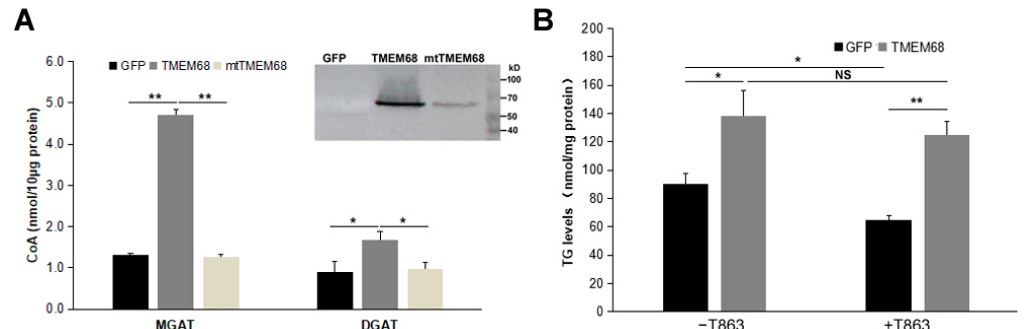
Figure 9. TMEM68 exhibites MGAT and DGAT activities. ( A ) Total membrane protein was extracted from 293/GFP, 293/TMEM68 and 293/mtTMEM68 cells. MGAT and DGAT activities of TMEM68 were measured by monitoring the released CoA from oleoyl-CoA in a TMEM68-mediated reaction containing 2-oleoyl-glycerol or 1-2-dioleoyl- sn -glycerol as the acceptor of oleoyl group. Immunoblot analysis of total membrane fraction isolated from HEK293 cells stably expressing GFP and TMEM68-GFP, transient expressing mtTMEM68. Migration of molecular mass standard proteins was indicated right of the figure. Data were presented as means ± SD. Asterisk indicated p values: * p < 0.05, ** p < 0.01, n = 3. ( B ) TG levels assays in HEK293 cells overexpressing GFP or TMEM68 in the absence or presence of T863. Cells were pretreated with T863 for 1 h or not, and then incubated with OA for 6 h. TG levels were quantified by an enzymatic triglyceride assay kit. Data were presented as means ± SD. NS, no significance. Asterisk indicated p values: * p < 0.05, ** p < 0.01, n =